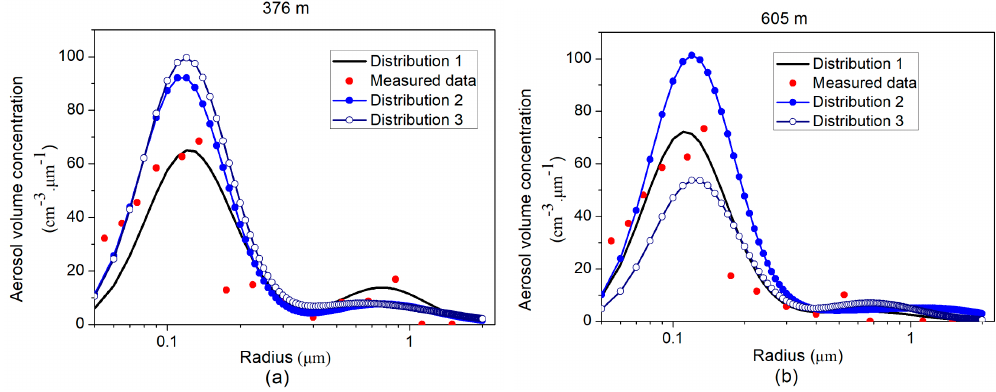
Figure 7. Comparison of the aerosol distribution and inversion distribution detected at two heights of ( a ) 376 m and ( b ) 605 m. The red dot is the aerosol volume concentration distribution measured by PCASP-100X, distribution 1 (dark line) is the retrieved data from the error-free data, distribution 2 (blue dot–solid line) is the retrieved data from the data with 10% systematic error and the distribution 3 (navy circle–hollow line) is the result from the data with 15% random error.